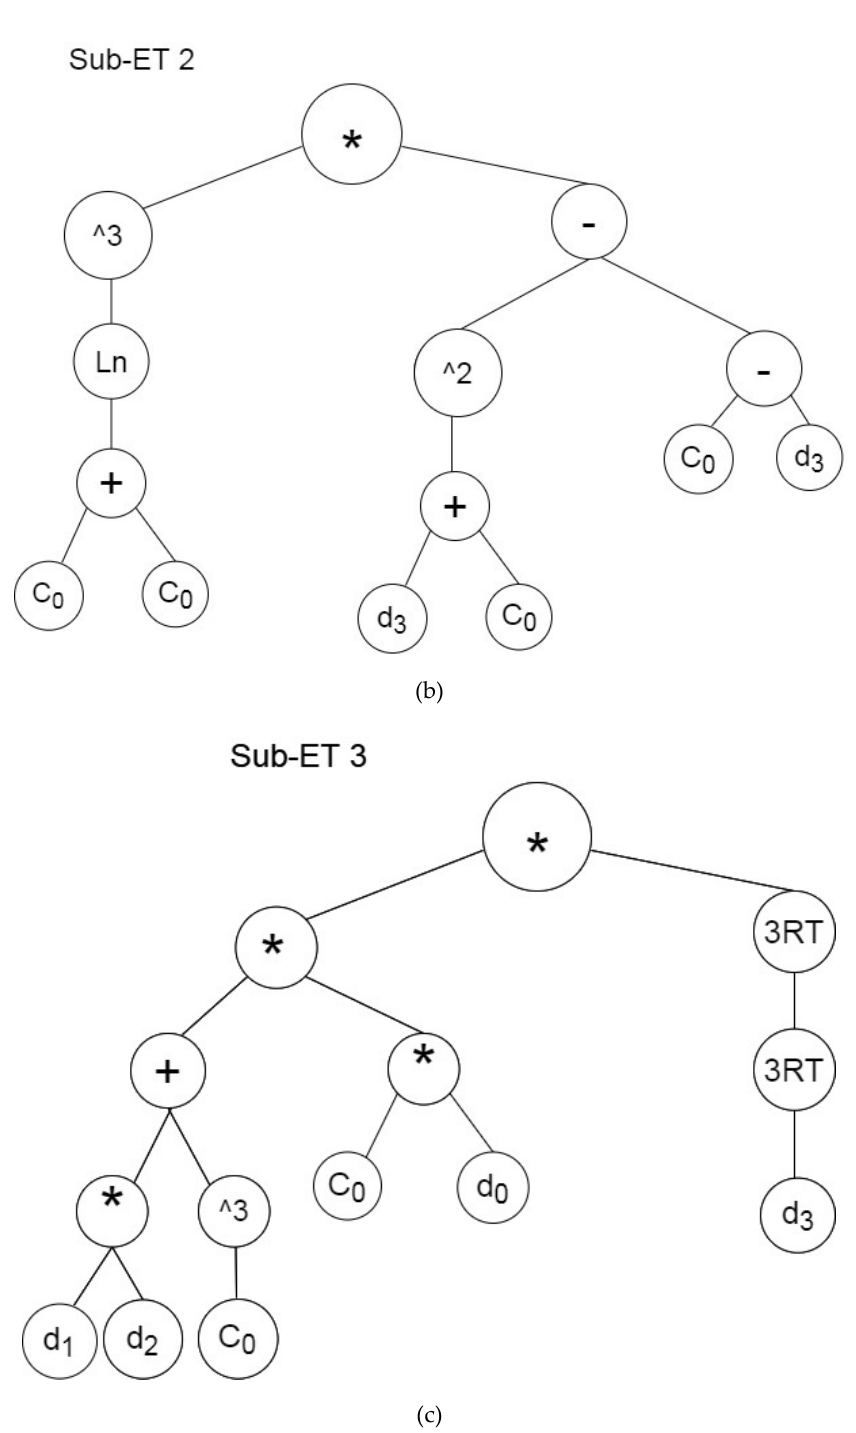
Figure 11. Expression trees (ETs) of Gene Expression Programming (GEP1) for compressive strength ( a ) sub-ET1 ( b ) sub-ET2, ( c ) sub-ET3.